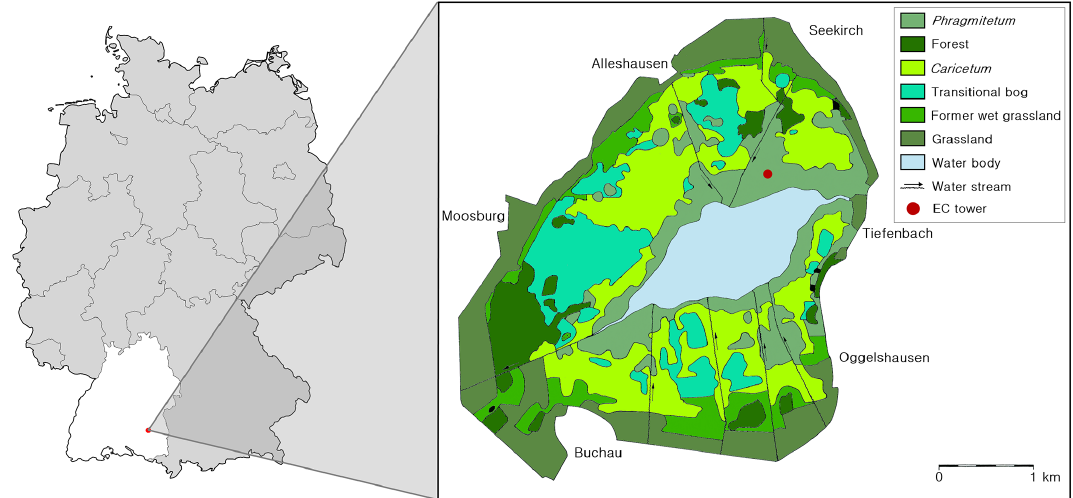
Figure 1. Land cover map of the nature conservation area, Federsee (adapted from Grüttner and Warnke-Grüttner, 1996), located in the Federal State of Baden-Württemberg, Germany. The EC (eddy covariance) tower was built north of the lake, in the center of the largest reed